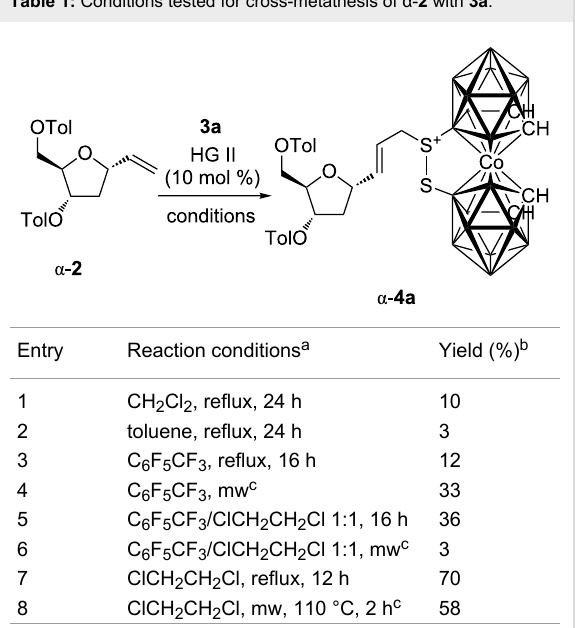
Table 1: Conditions tested for cross-metathesis of α - 2 with 3a .